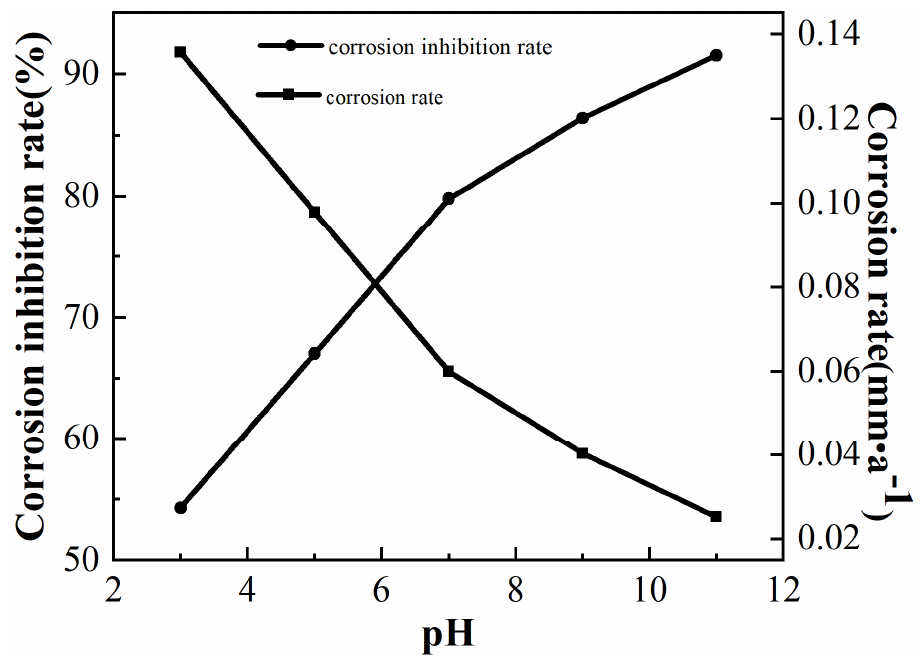
Figure 9. Influence of water sample pH on corrosion inhibition.